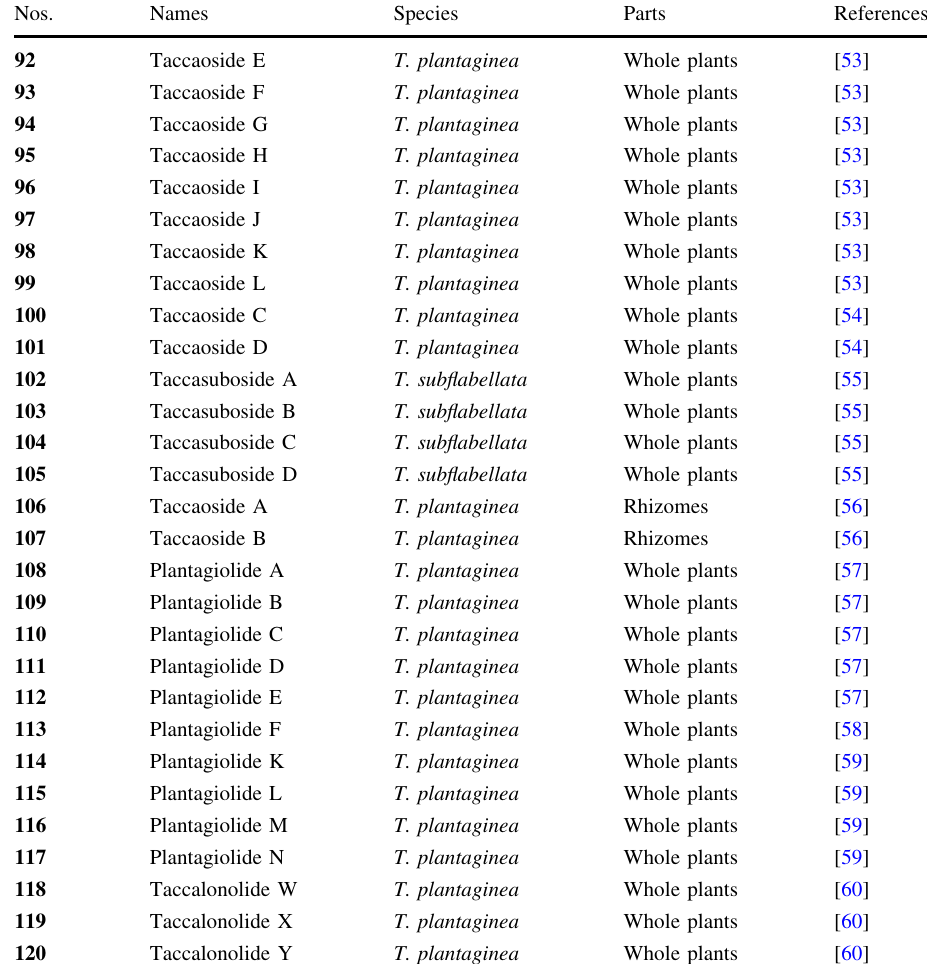
Table 4 New steroidal sapogenins and saponins from Tacca species